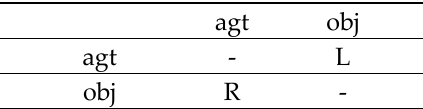
Figure 7. Precedence matrix of UNL relations for ‘agt’ and ‘obj’.